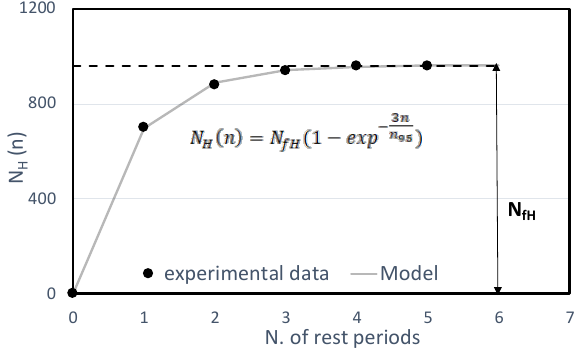
Figure 3. Self-healing contribution versus number of rest periods.